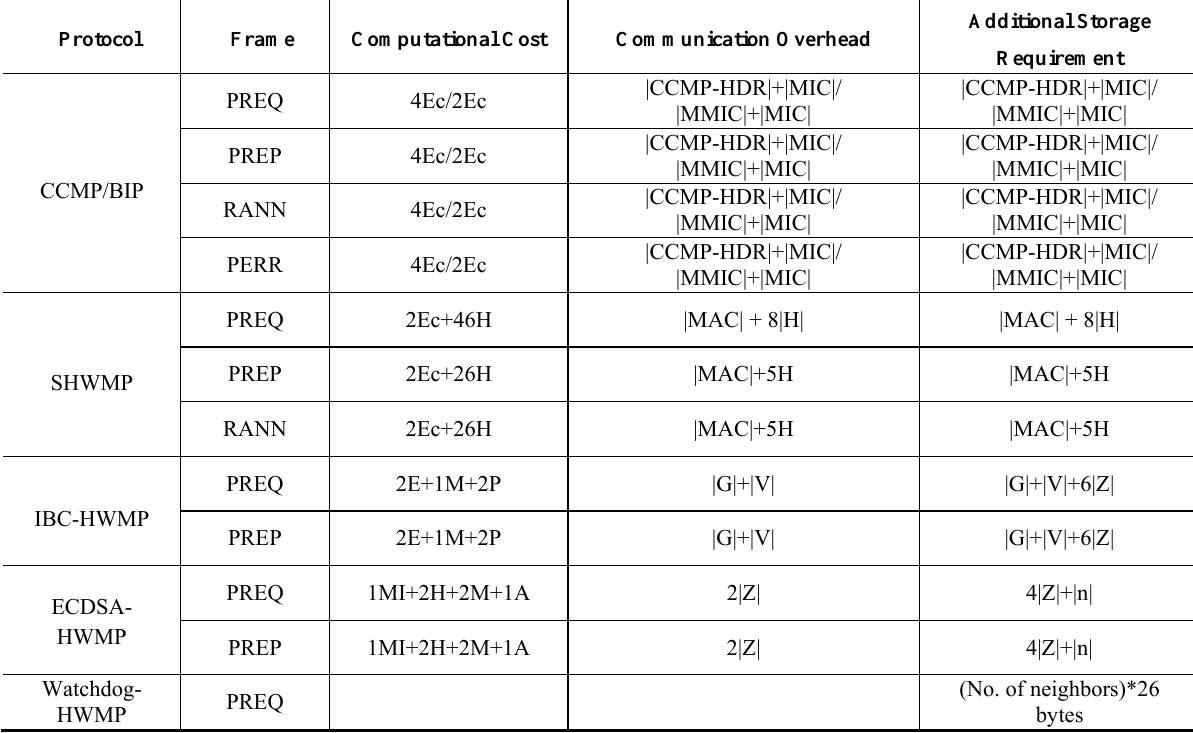
Table 13. The Comparison of computational complexity for Secure HWMP protocols. The numbers of computation are only counted for one hop